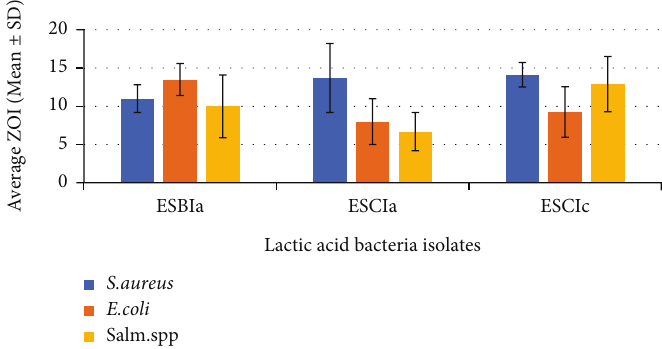
Figure 6: Average inhibition zones of antimicrobial activity of CFS of LAB isolates against indicator bacteria.